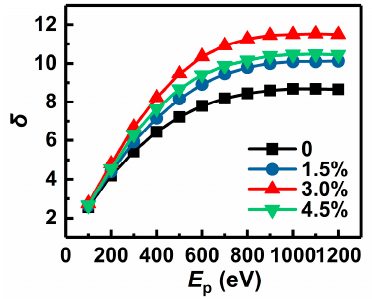
Figure 1. δ – E p curves of an undoped MgO film sample and three Au-doped MgO film samples with doping concentrations of 1.5%, 3.0%, and 4.5%. doping concentrations of 1.5%, 3.0%, and